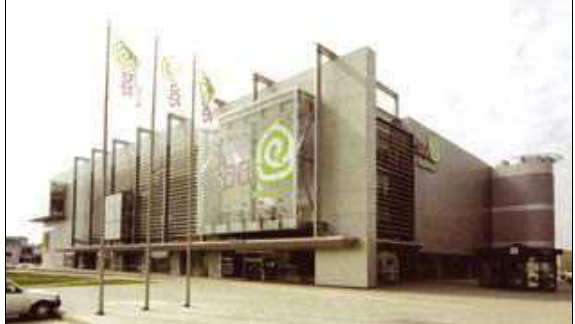
Fig. 12. Lighting showr­oom in